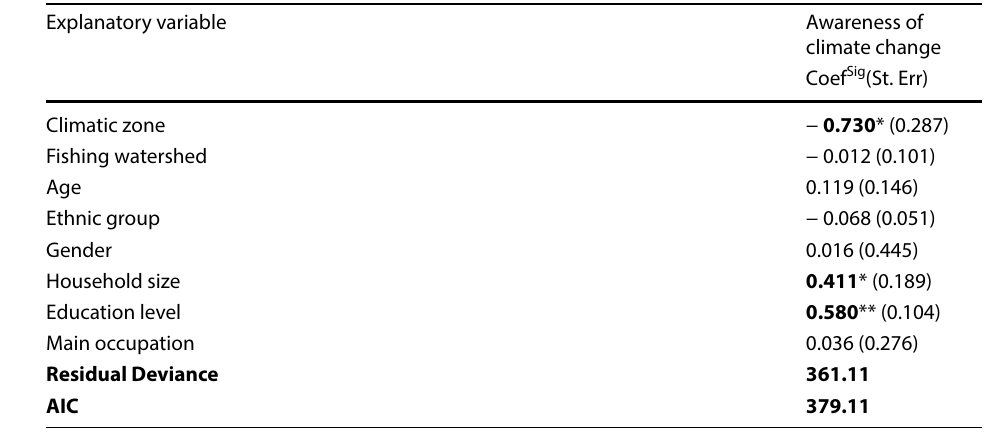
Table 7 Results of multinomial logistic regression of socio-demographic factors determining Ivorian fishermen’s perception of change in climate